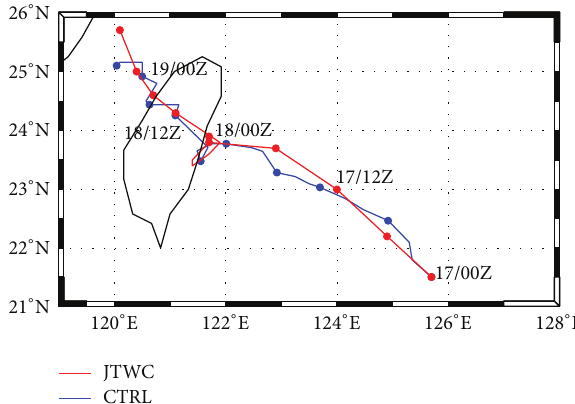
Figure 1: Comparison of the best track (red) and the simulated track (blue) of Typhoon Haitang from CTRL experiment. Each dot denotes Haitang’s central position every 6 h.